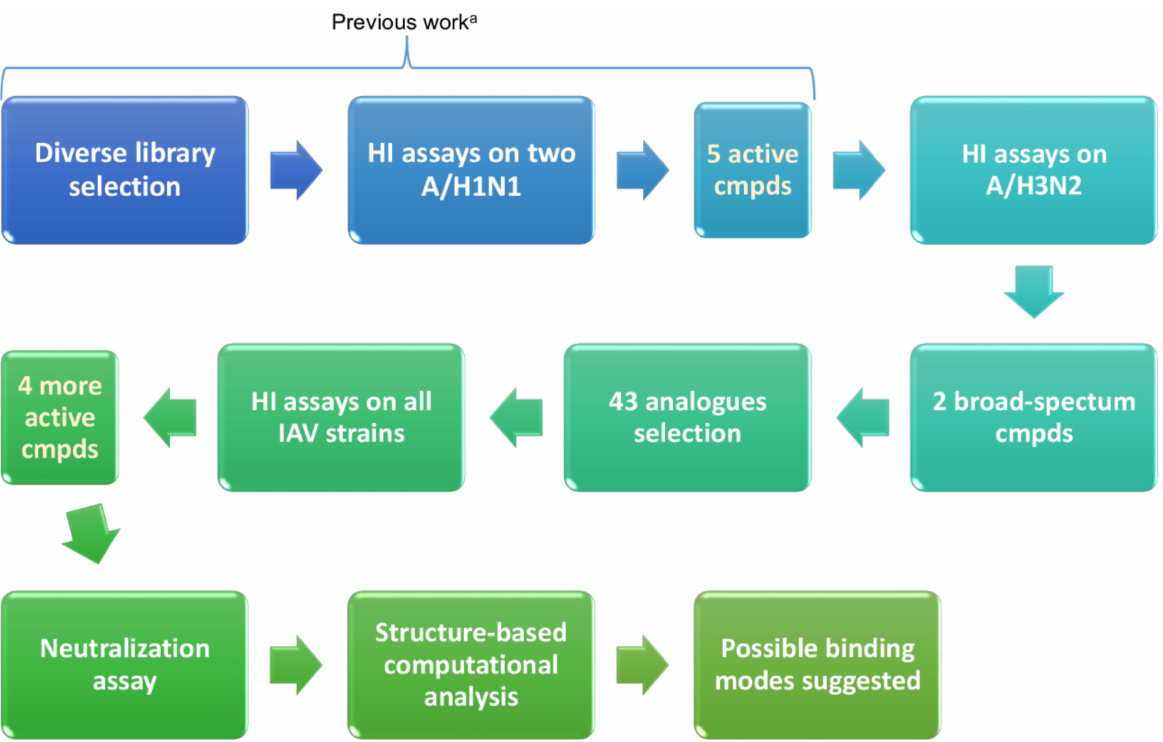
Figure 2. Schema reporting the step-by-step procedure applied. a This part of the workflow is reported in a previous article